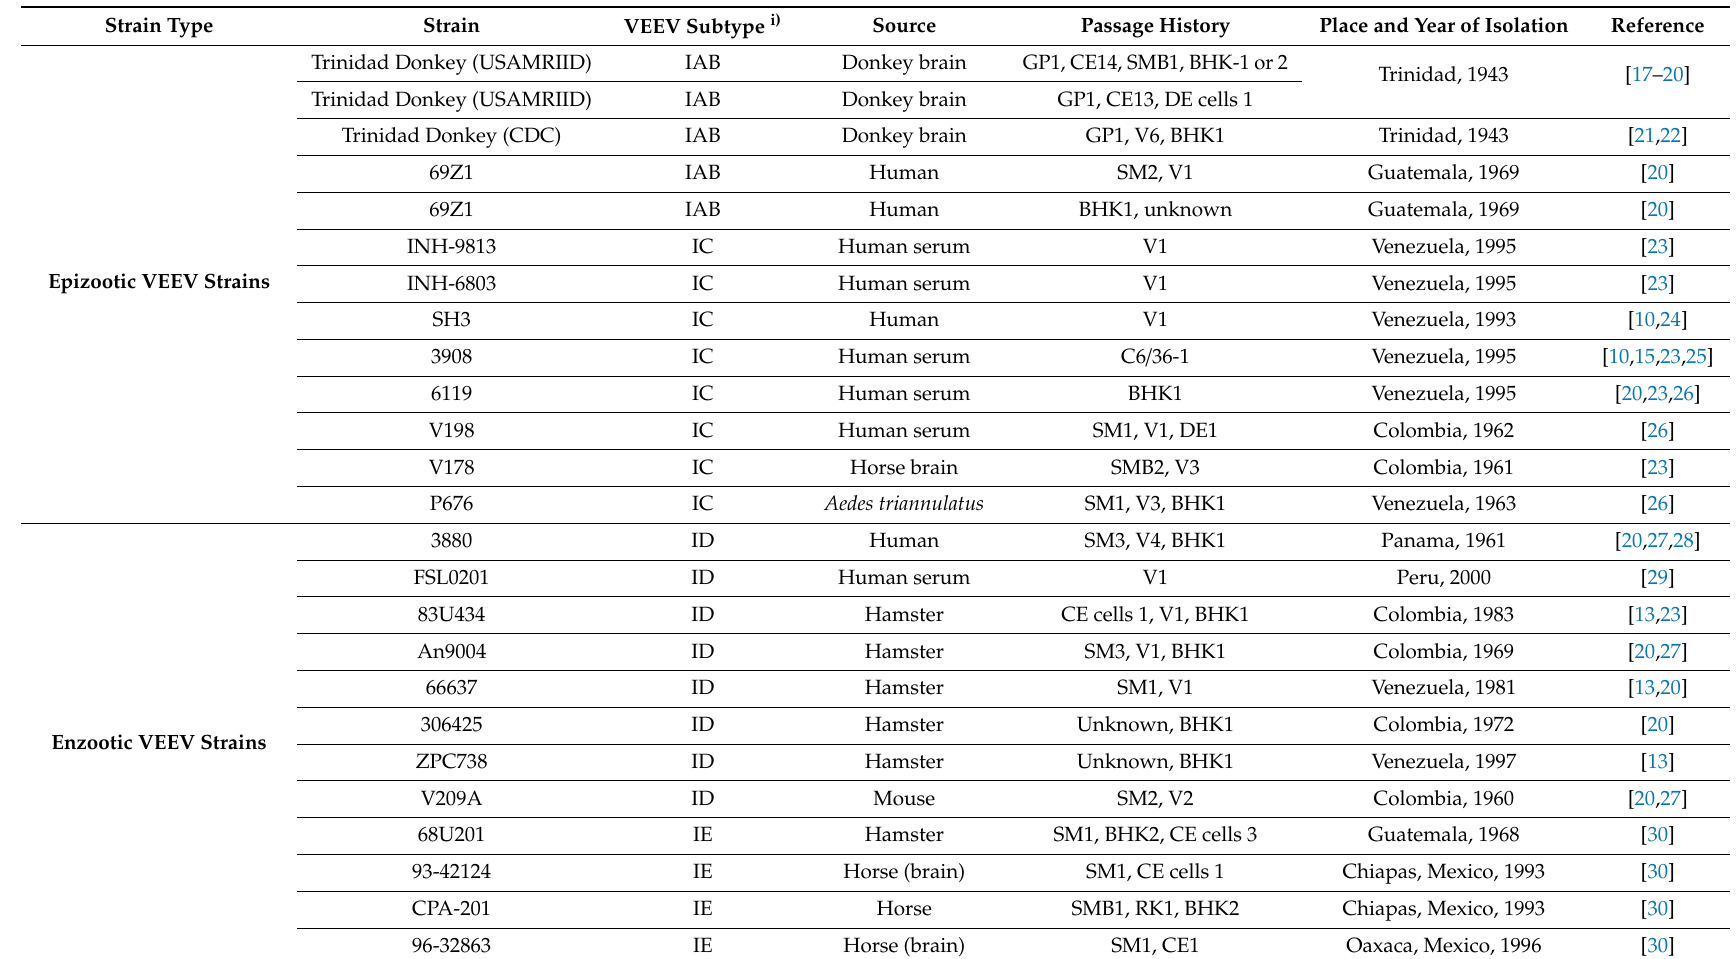
Table 2. VEEV epizootic (IAB, IC) and enzootic (ID, IE)